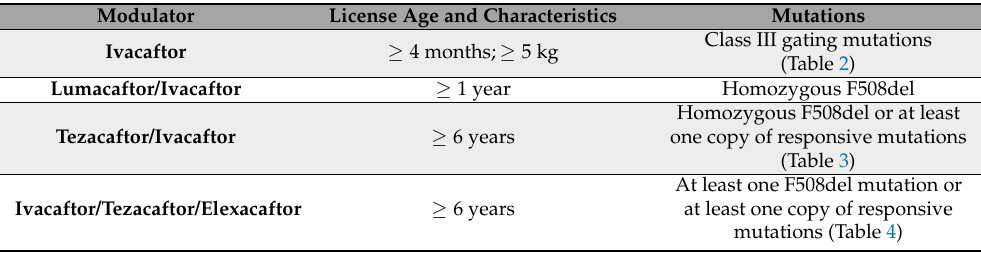
Table 1. Summary of licensed CFTR modulator approved by FDA (https://www.vertexgps.com, accessed on 31 October 2022); worldwide data are available from https://news.vrtx.com, accessed on